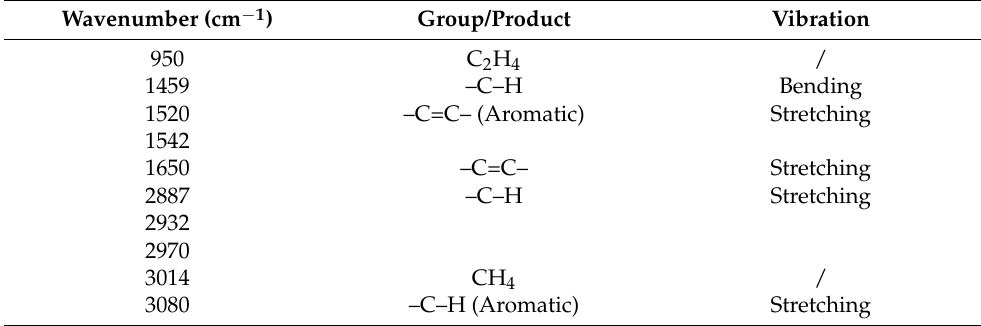
Table 6. A summary of IR bonds identified by the FTIR absorption bands of the typical func- tional